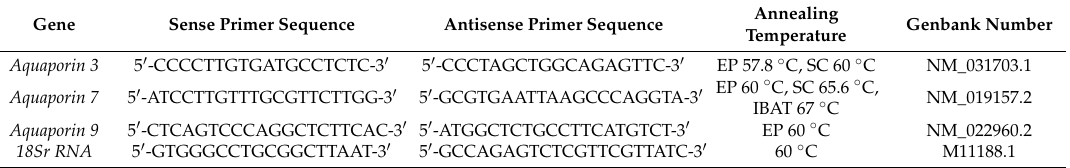
Table 3. Primer sequences and annealing temperatures for RT-PCR amplification of each gene